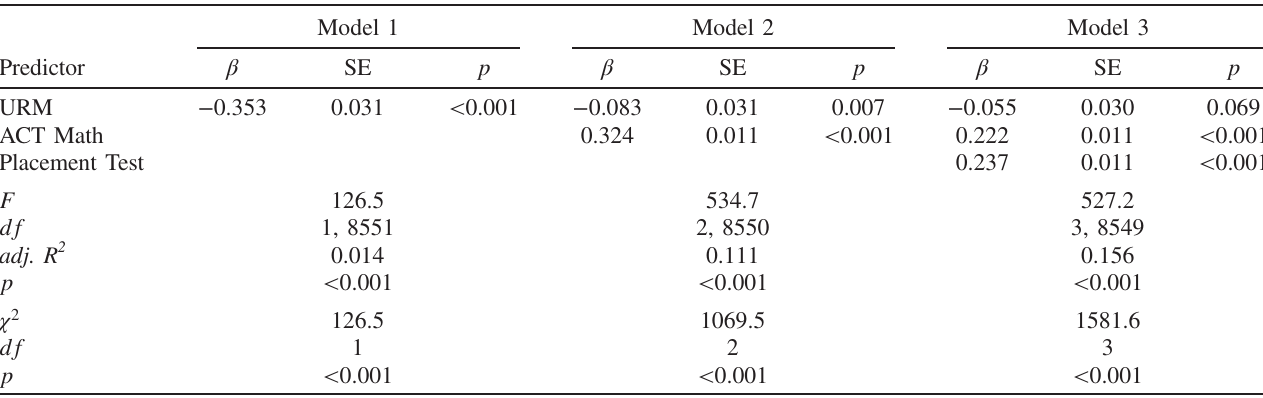
TABLE IV. Binary models predicting physics 1 final exam